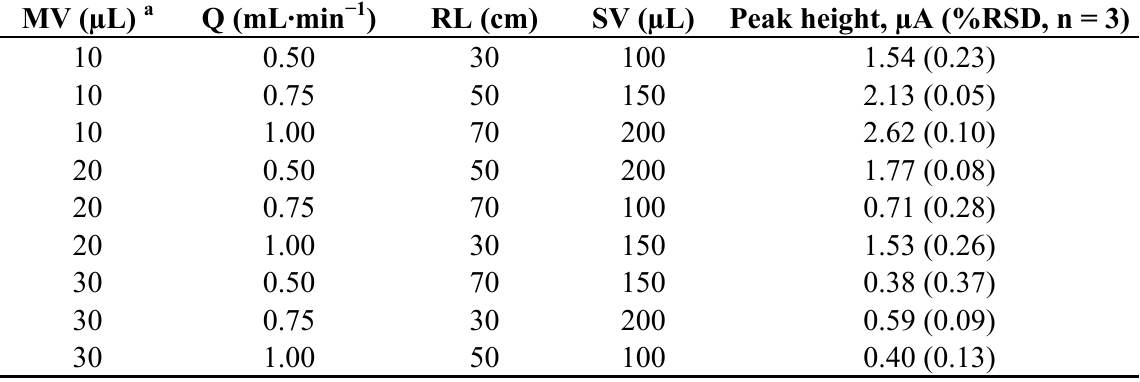
Table 1. L (3 4 ) orthogonal array and peak height in each experiment. 9